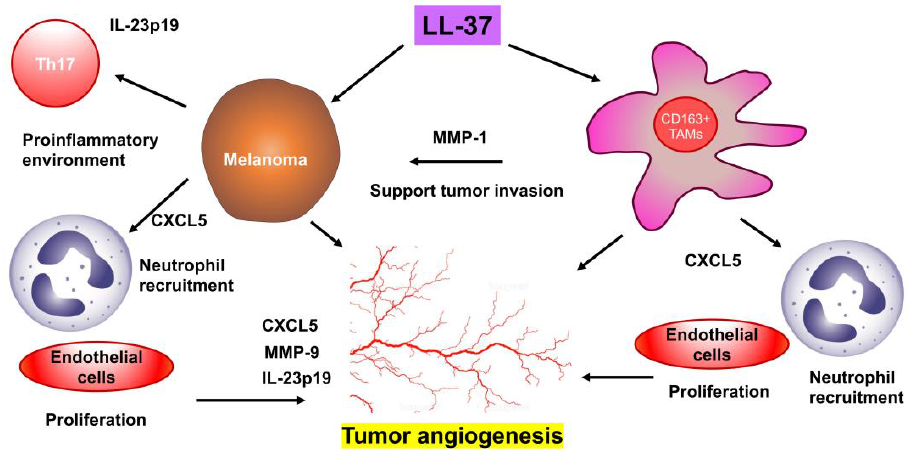
Figure 6. Summary of the present study.